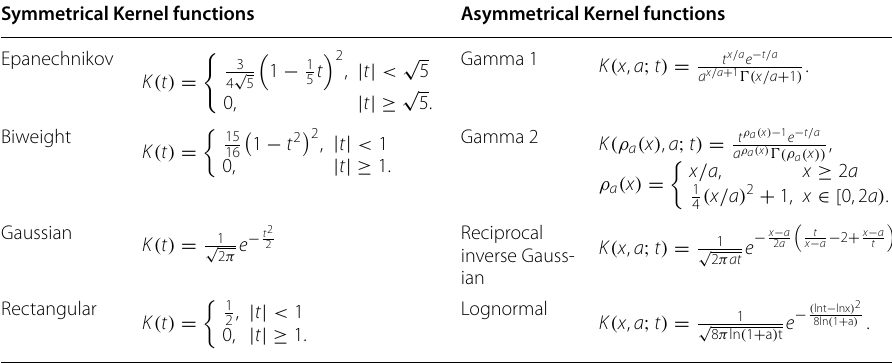
Table 5 Examples of symmetrical and asymmetrical kernel functions [46] Symmetrical Kernel functions Asymmetrical Kernel